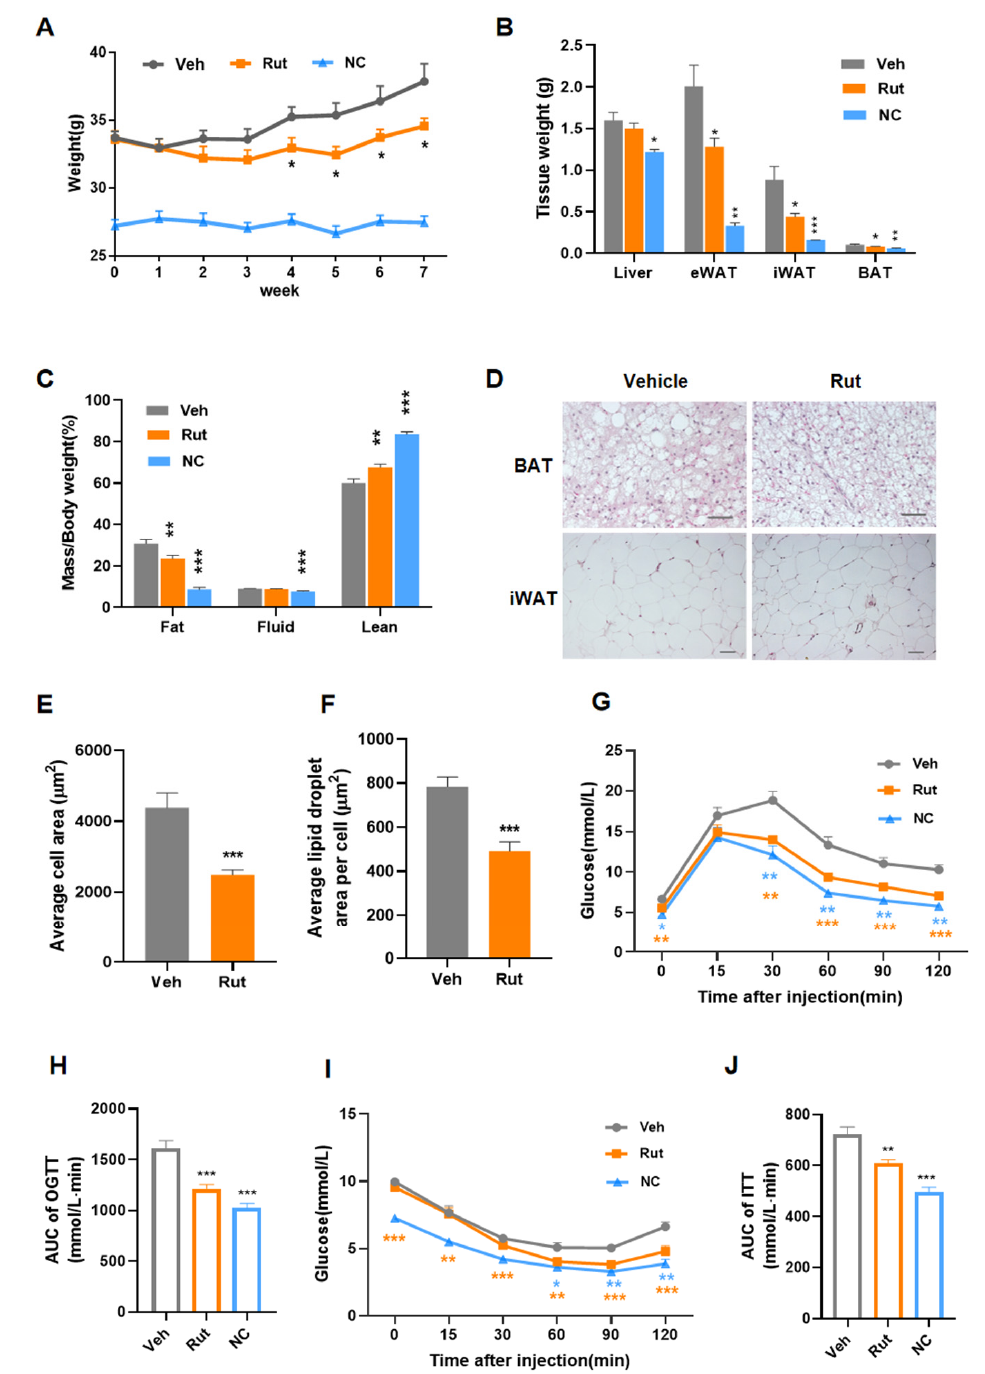
Figure 3. Rut restrains the weight gain of HFD-fed mice and ameliorates insulin resistance. ( A ) Body weights were recorded each week after Rut treatment. ( B ) Tissues were collected and weighted. ( C ) Proportion of body composition of mice. ( D ) Representative hematoxylin and eosin staining (HE staining) from interscapular BAT and inguinal WAT sections of HFD-fed mice after 8 weeks of Rut treatment. Scale bar, 50 µ m. ( E , F ) Quantification of adipocyte area of iBAT ( E ) and iWAT ( F ). ( G ) Blood glucose curves during testing of oral glucose tolerance (GTT). ( H ) Area under curve (AUC) of GTT. ( I ) Blood glucose levels were plotted in insulin tolerance test (ITT). ( J ) Analysis of AUC during ITT. n = 6 per group. Data are presented as the means ± SEM. Student’s t -test. * p < 0.05, ** p < 0.01, *** p < 0.001 compared with the indicated control